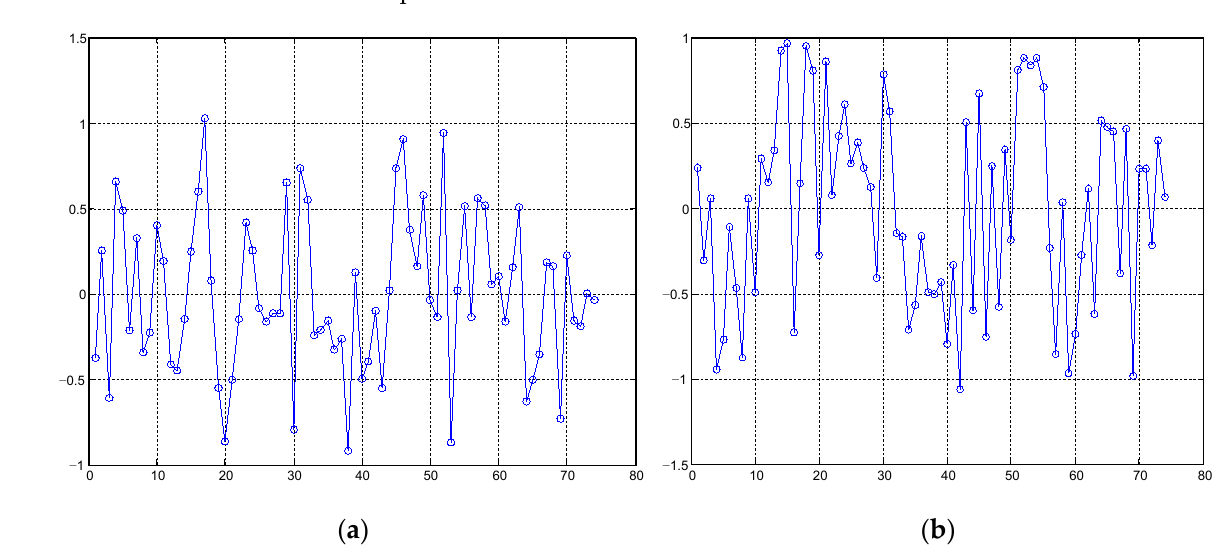
Figure 15. Matching error of the tie-points between strips, where ( a ) is the slant range direction and ( b ) is the azimuth direction.